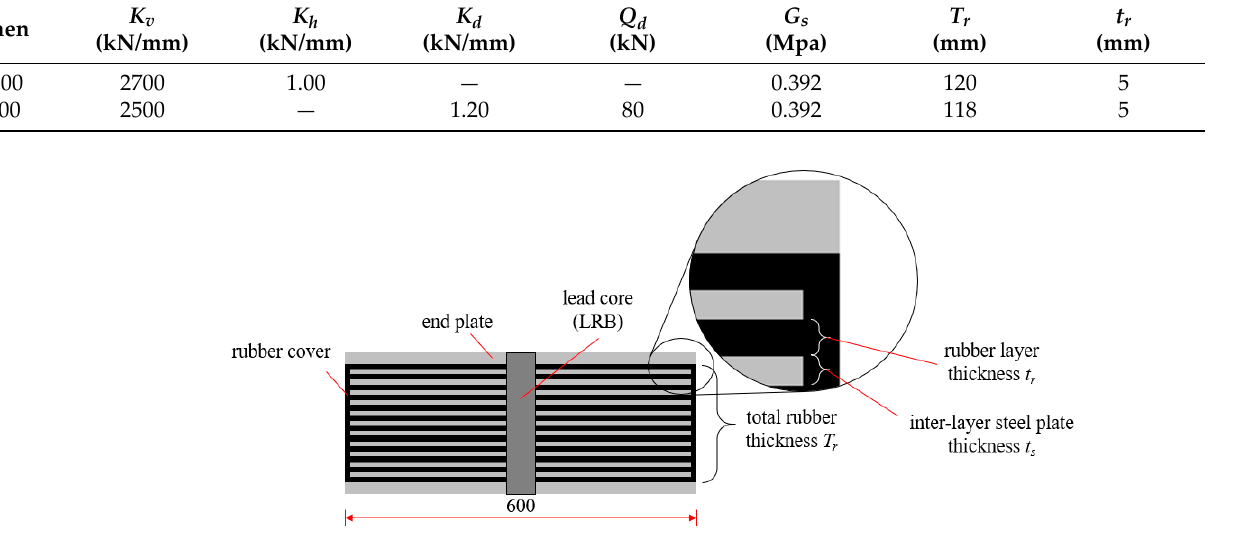
Figure 2. Profile of the specimen (unit: mm) Table 1. Mechanical properties of the rubber bearings Table 1. Mechanical properties of the rubber bearings.